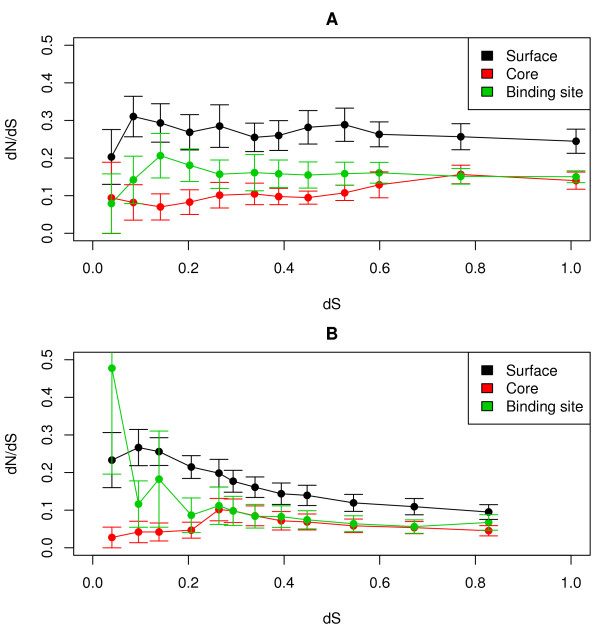
dN/dS vs dS (proportional to simulation time) for surface (black), core (red) and binding site (green) residues is shown. Values reflect the mean of the most common allele in each population, with standard error bars indicating inter-population variation. Simulations using the informational scoring function in A), simulations using the physics-based scoring function in B).